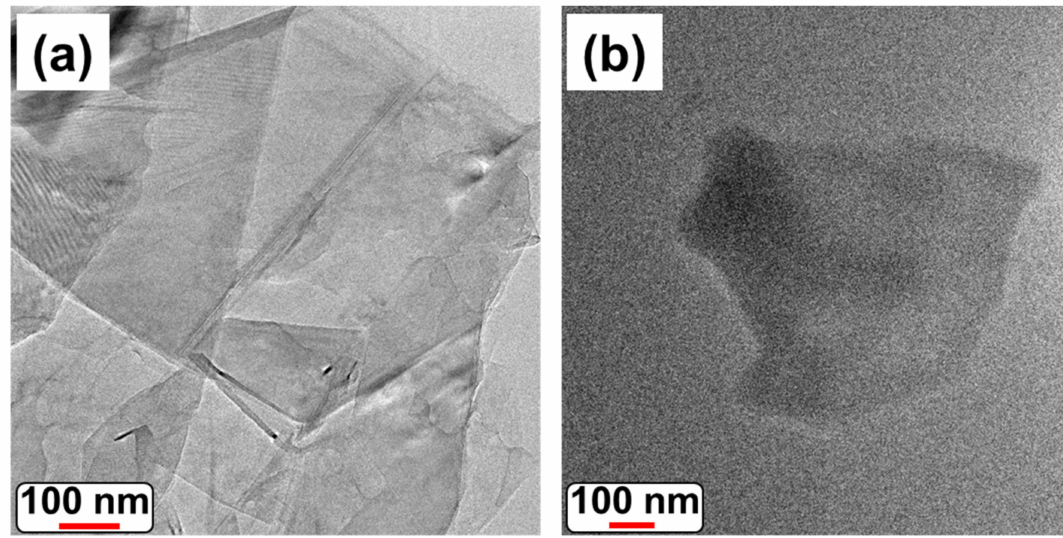
Figure 3. ( a , b ) HRTEM images of GPNVP